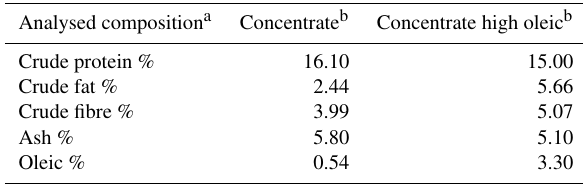
Table 1. The chemical composition of dietary ingredients. Analysed composition